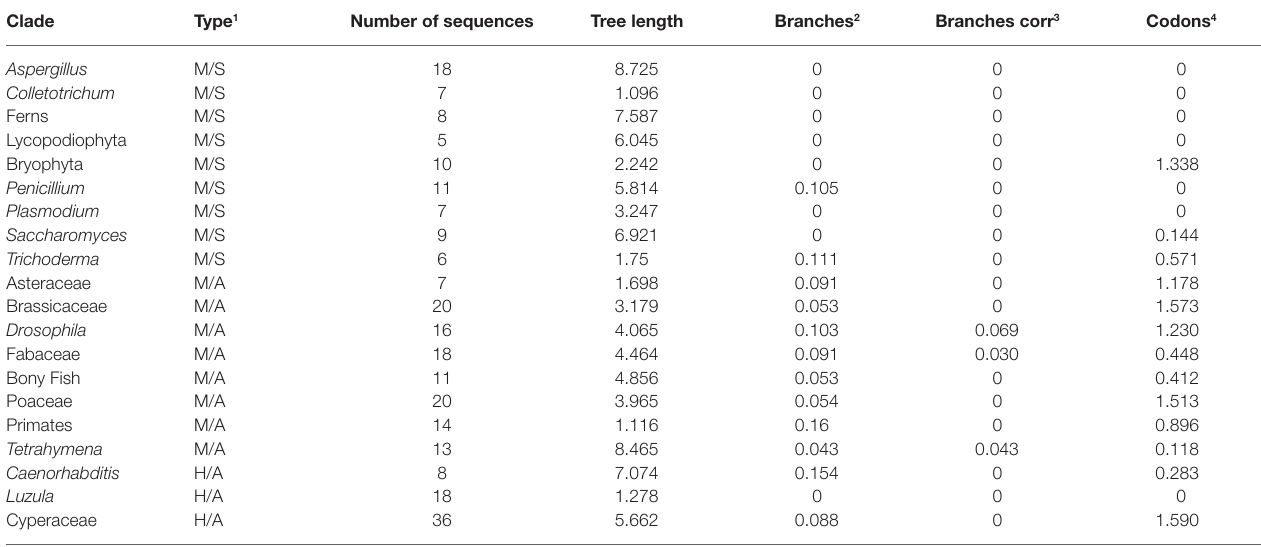
TABLE 1 | Fraction of positively selected branches and codons in Cyperaceae and other clades. Clade Type